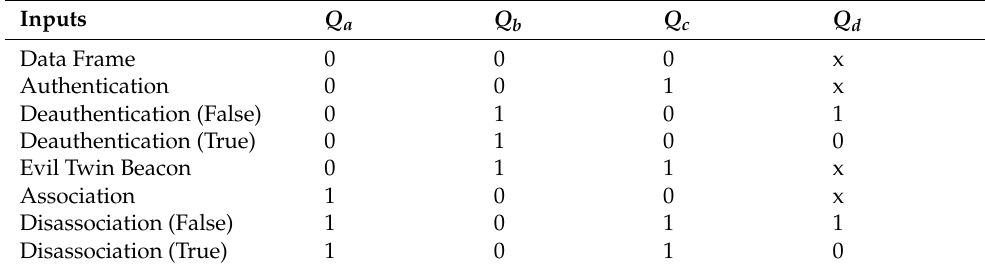
Table 2. State machine inputs.